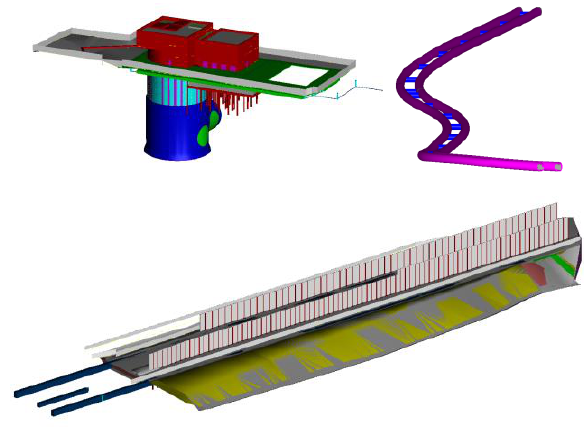
Figure 1:IFC Models of Vent Shaft (Top Left), Tunnel (Top Right) and Embankment (Bottom)